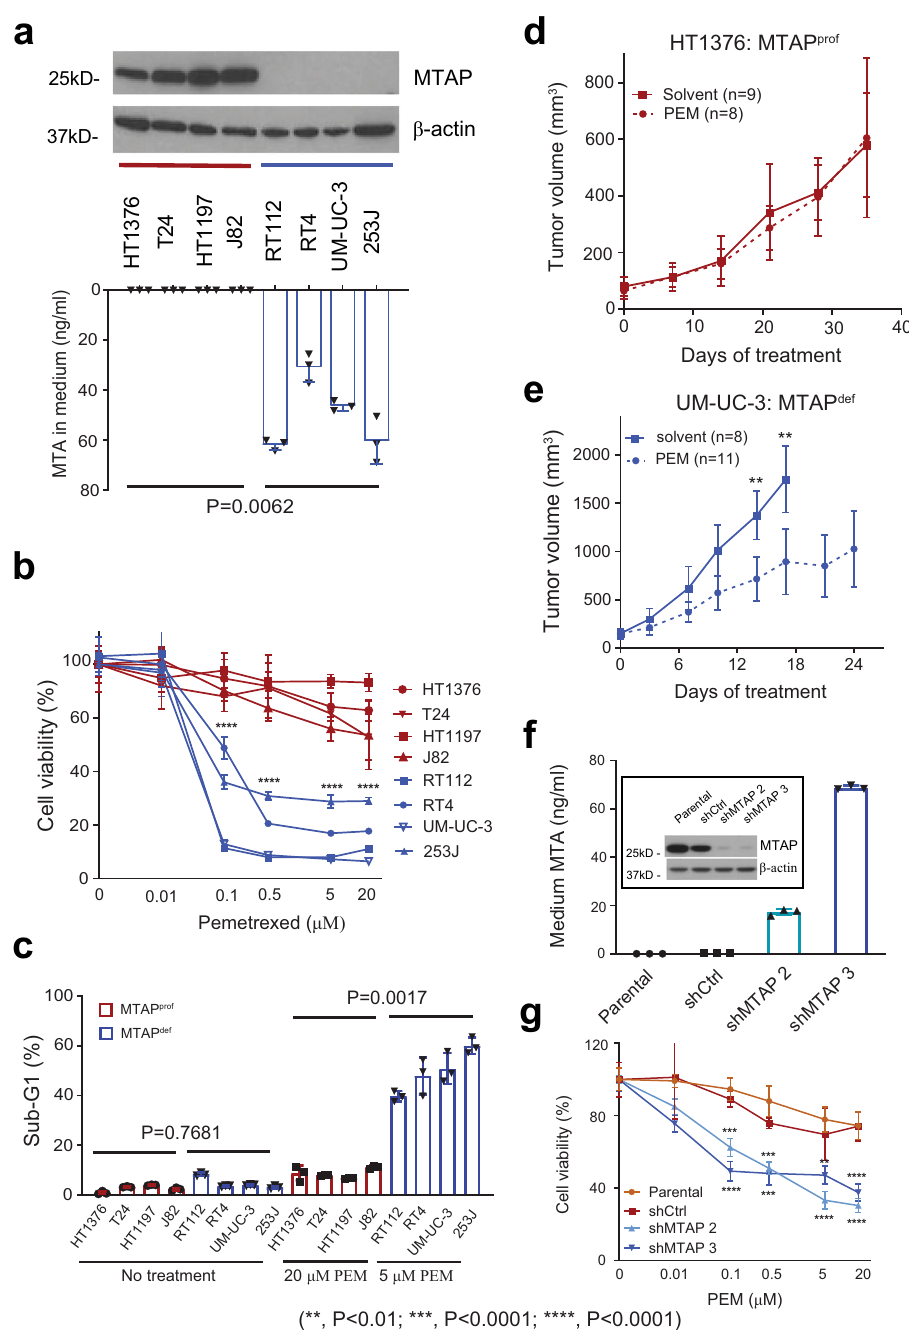
Fig. 2 In vitro and in vivo effects of pemetrexed on human UC based on MTAP protein status. a Western blot veri fi cation of MTAP protein loss in four MTAP def vs four MTAP prof human UC cell lines paired with UHPLC-ESI/triple quadrupole mass spectrometry measuring MTA concentration in cell media of human UC cell lines (ng/mL). MTA levels are signi fi cantly higher in MTAP def compared to MTAP prof cell lines P value was calculated by Welch T test. b Sub-G1 analysis of MTAP def and MTAP prof cell lines when treated with 0.5 μ M and 20 μ M of pemetrexed (PEM). P value was calculated by Mann- Whitney test. c Cell viability after treatment with increasing concentrations of pemetrexed is signi fi cantly higher in MTAP prof compared to MTAP def cell lines P value was calculated by two-way ANOVA. d, e Xenograft tumor volume in HT-1376 and UM-UC-3 when treated with pemetrexed vs solvent. P value was calculated by two-way ANOVA. f Western blot and UHPLC-ESI/triple quadrupole mass spectrometry con fi rmation of MTAP knockdown in two HT-1376 cell lines: shMTAP2 and shMTAP3. g Pemetrexed resulted in signi fi cantly lower viability in the transfected HT1376 compared to the parental cell lines, with or without transduction of the lentivirus control vector. P value was calculated by two-way ANOVA. Data in a (bottom panel), b – e , f (bottom panel), and g are presented as mean + / −